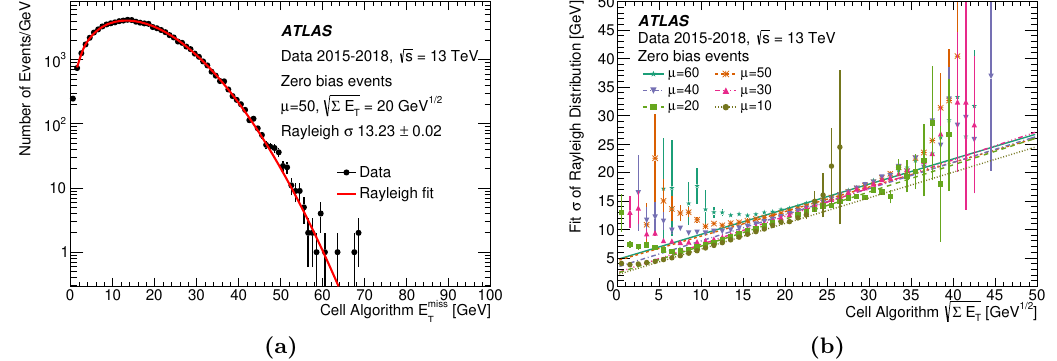
Figure 13. Data and (cid:12)ts to data for E miss E miss T